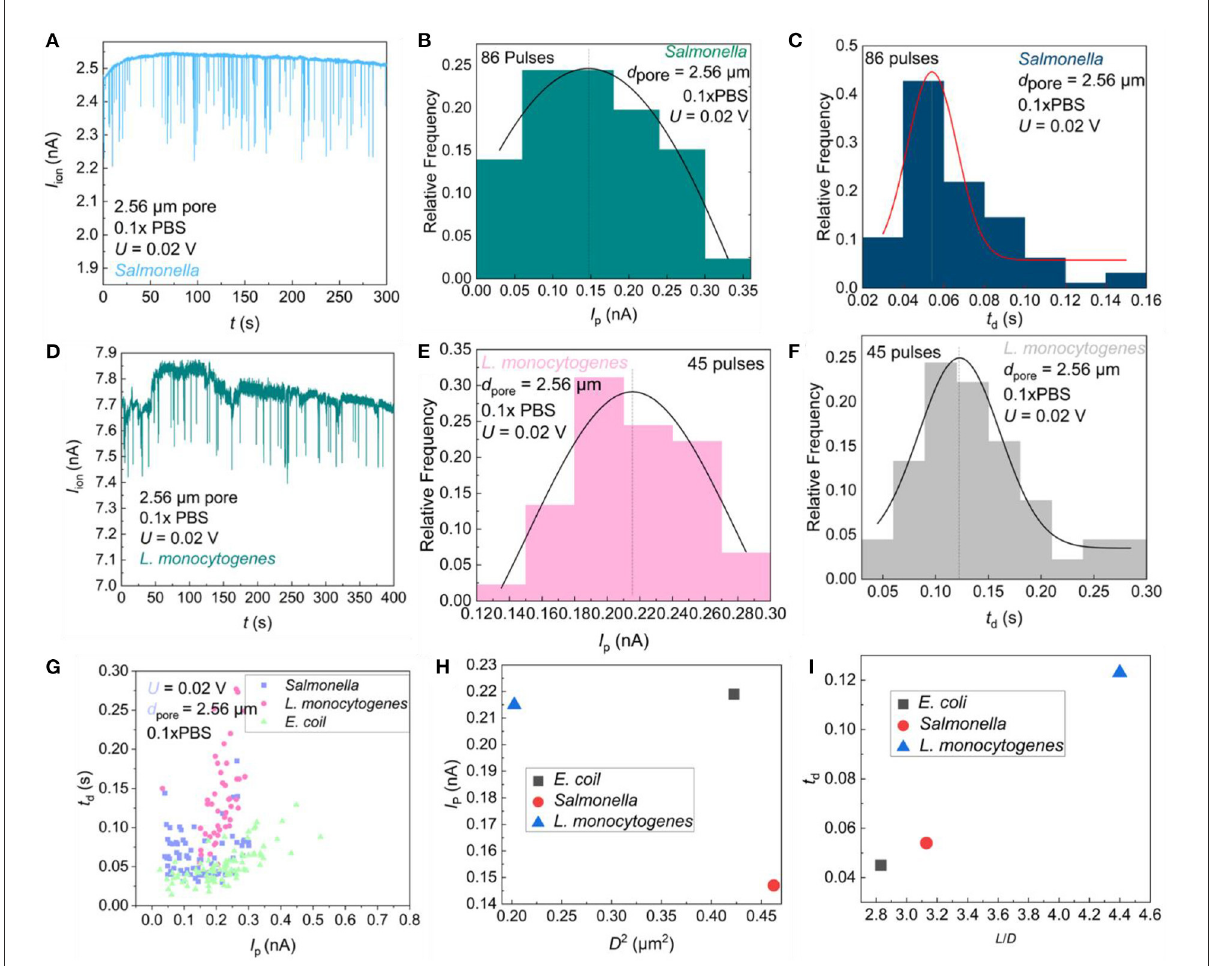
FIGURE6 Statistical analysis of resistance pulses. I ion vs. time ( t ) trace recorded in 0.1 × PBS containing S. enterica (A) and L. monocytogenes (D) with a single pore of diameter d pore = 2.56 µ m under U = 0.02V; Frequency distribution of S. enterica (B) and L. monocytogenes (E) resistance pulse height; Frequency distribution of S. enterica (C) and L. monocytogenes (F) resistance pulse width; (G) The pulse height I p vs. width t d scatter plots of three bacterial; (H) Scatter plot of expected pulse height I p vs. square of bacterial diameter for three bacteria; (I) The pulse width expected value t d vs. bacterial aspect-ratio scatter plots of three bacteria.